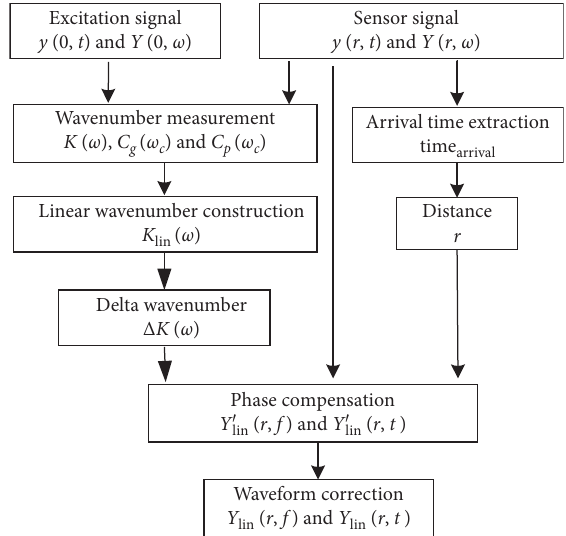
Figure 5: Schematic of ∆ K-DC for the measured